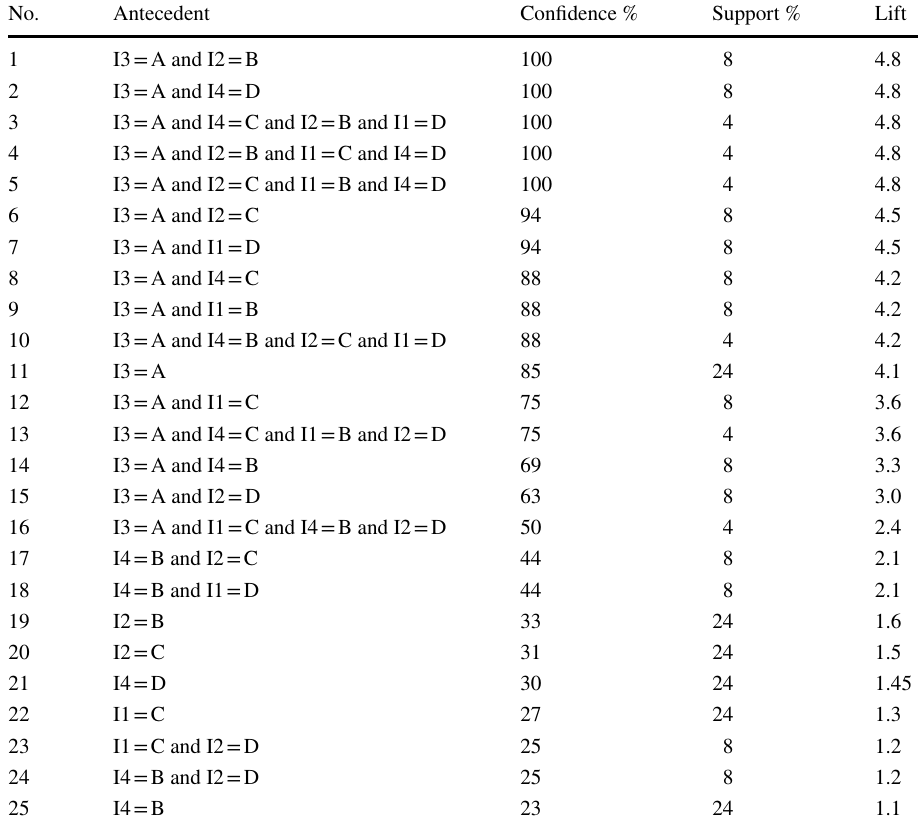
No. Antecedent Confidence